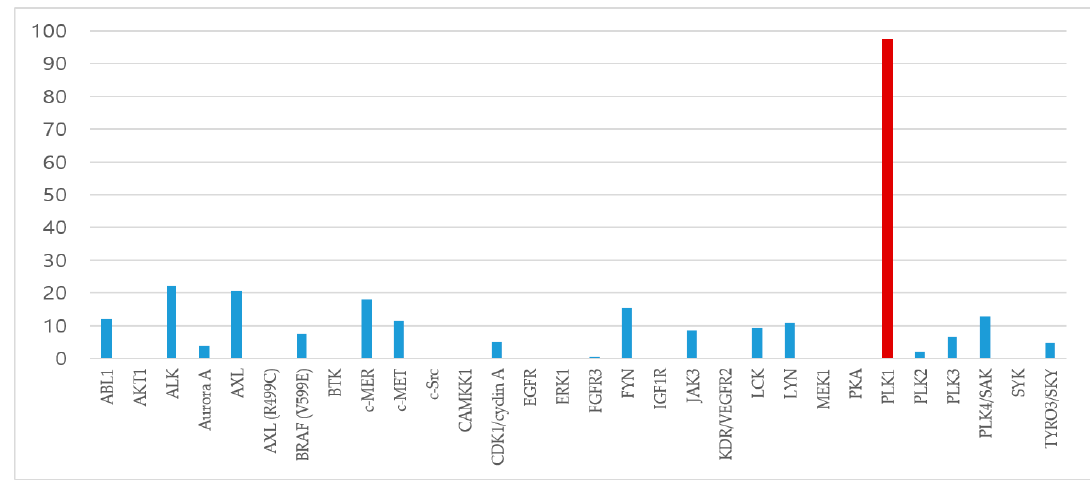
Figure 5. Percentages of enzymatic inhibition exerted by 15 (10 µM) on 30 selected protein kinases [21] .